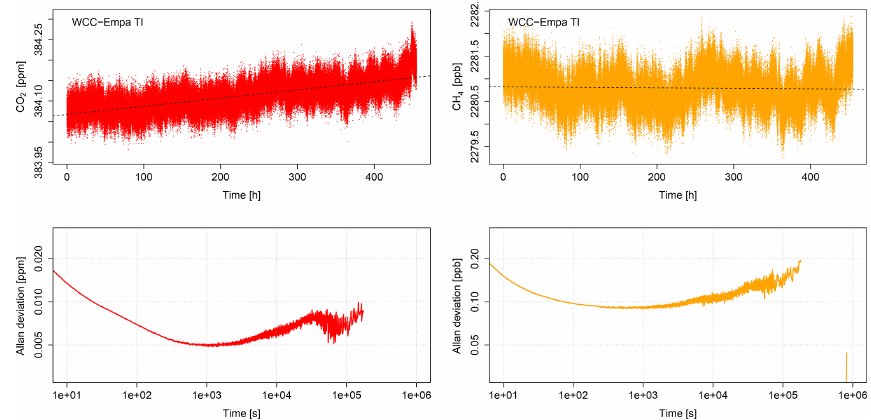
Figure 4. Upper left panel: CO 2 working standard measured over a period of 455h with the Picarro G2401 (S/N 1497-CFKADS2098) travelling instrument (5s averages). The black dashed line is the linear regression through all data. Lower left panel: Allan deviation plots based on the data above. Right: same for CH 4